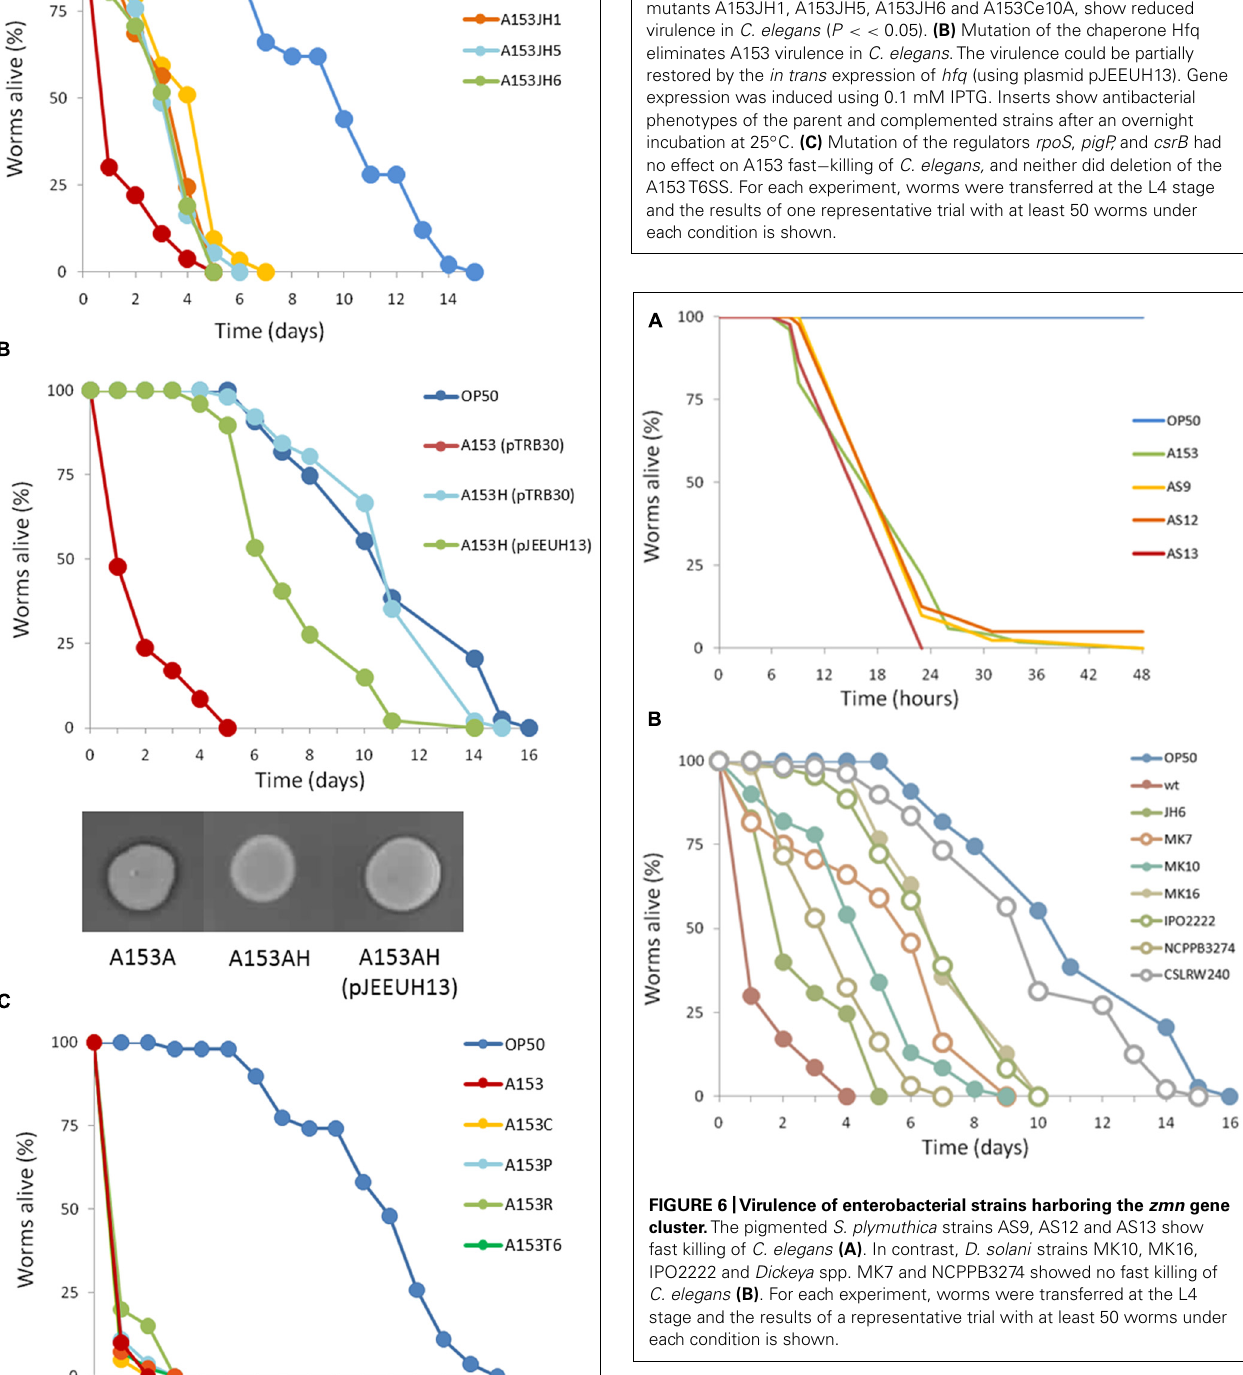
FIGURE 5 | Continued Kinetics of the nematicidal properties of Serratia plymuthica A153 strains. (A) Mutation of the zmn gene cluster attenuates S. plymuthica A153 fast killing of C. elegans . Compared with the A153A parent strain,